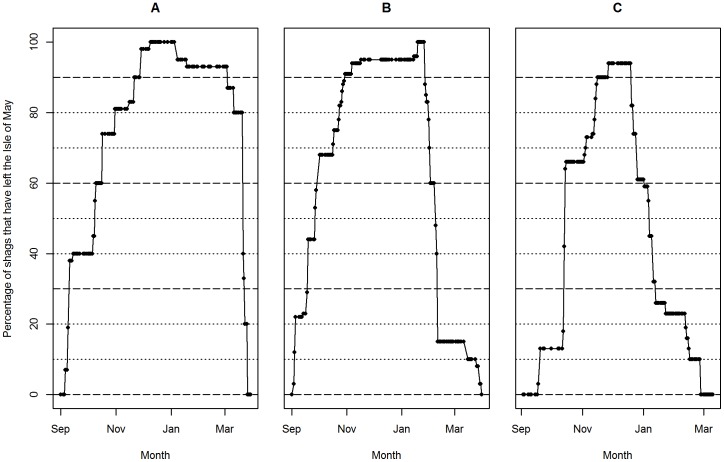
Movement boundaries.The percentages of colour-ringed adult shags known to have bred on the Isle of May that were resighted on or near the Isle of May and at an alternative winter site during winters A. 2009–2010, B. 2010–2011, and C. 2011–2012 that were away from the Isle of May on progressive dates. Dotted lines indicate 10% intervals, dashed lines denote the movement boundaries used to subset the data for repeatability analyses (0%, 30%, 60%, 90%).